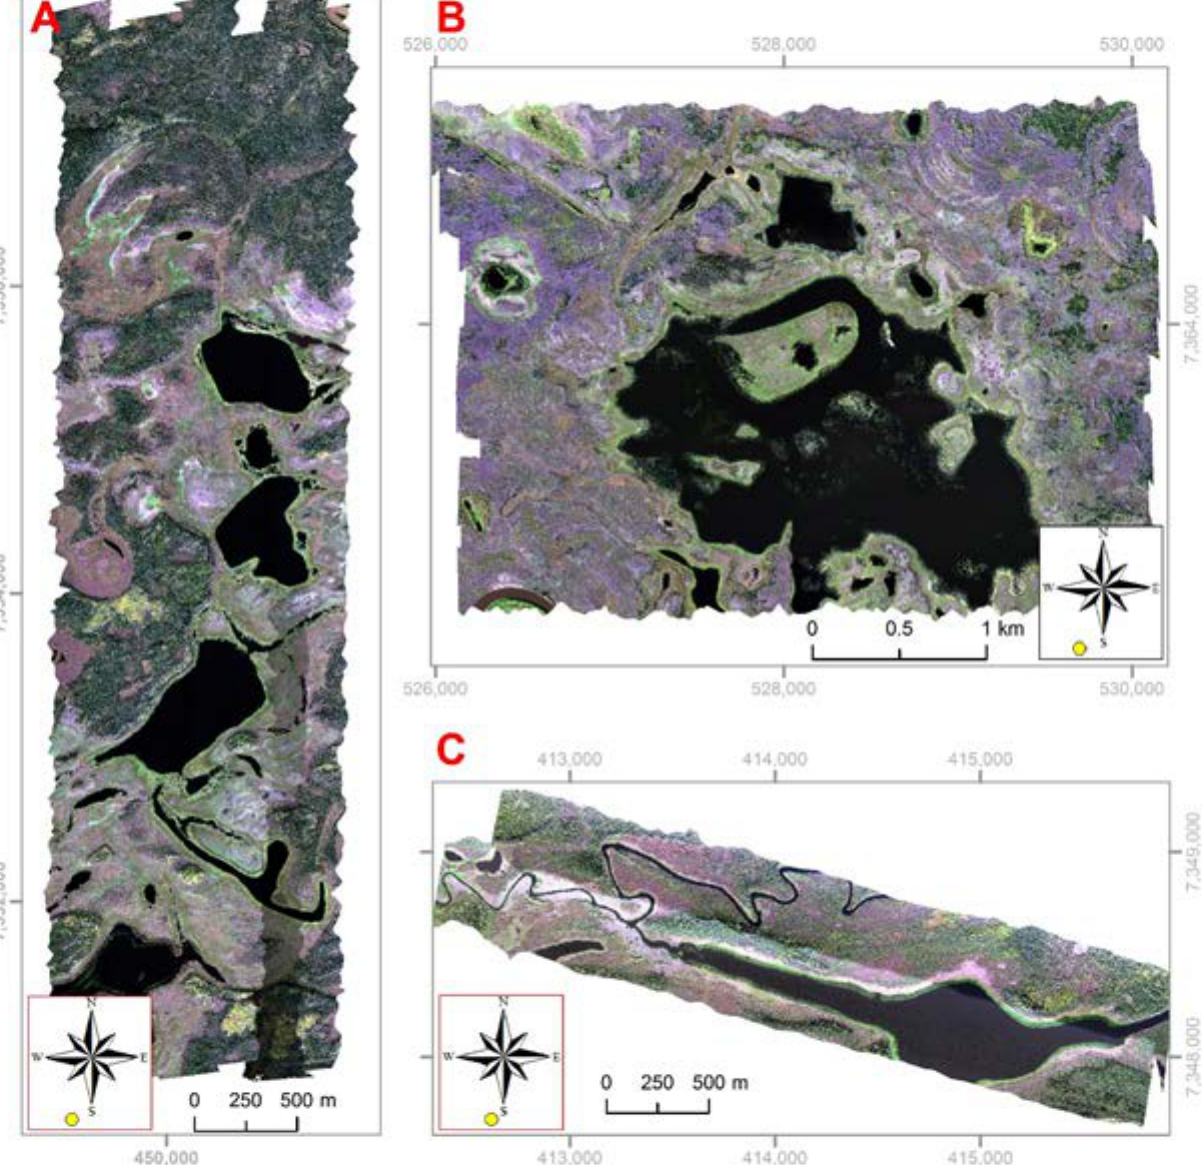
Figure 6. True color (red: band 38 (652 nm); green: band 22 (0.550 nm); blue: band 11 (481 nm)) orthomosaics for areas A , B , and C at a 1 m spatial resolution. A flight area shows a darkened flight line due to a low cirrus undetected when acquiring the imagery. C flight area shows Bidirectional reflectance distribution function (BRDF) effect between two flight lines flown northeast to southwest where the flight line at the top of the image is darker for the same ground cover type. The position of the sun is shown below the north arrow for each image. Coordinates are in UTM-6N and datum is in